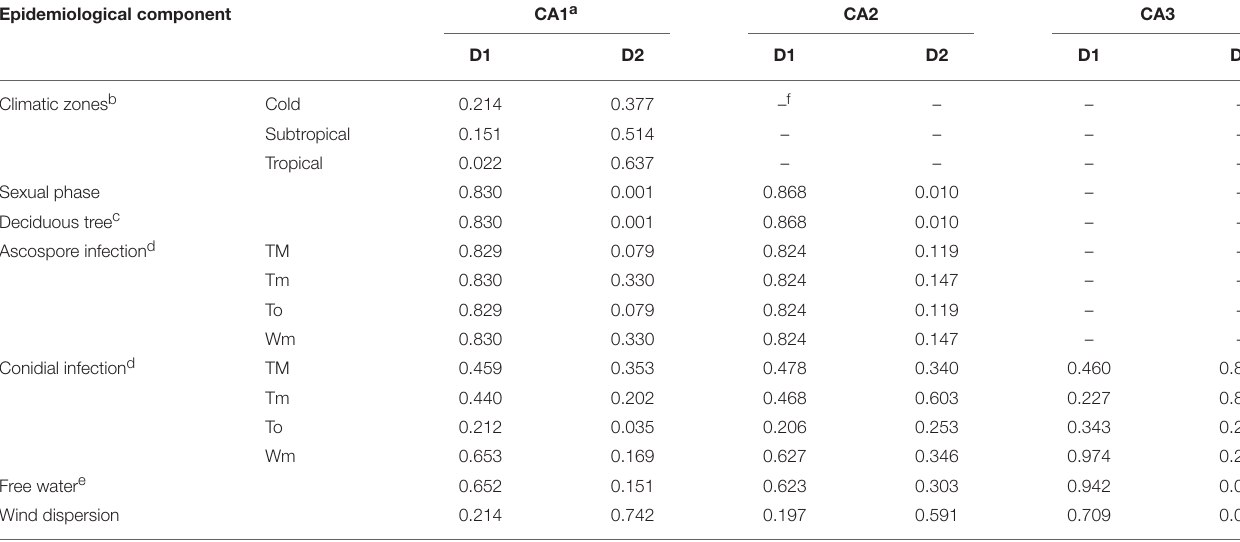
TABLE 6 | Discrimination values (DVs) of the epidemiological components used in different correspondence analyses (CA1, CA2, and CA3) and dimensions (D1 and D2). Epidemiological